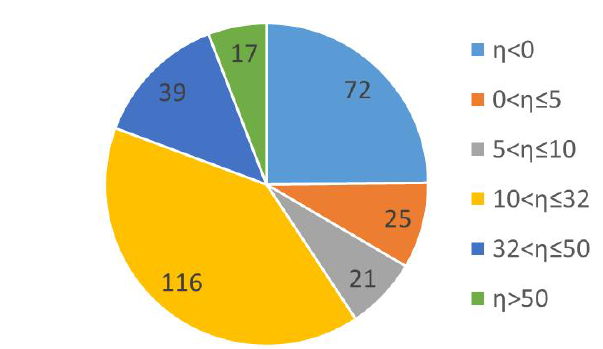
Figure 12—Recovery percent of 290 single sand bodies in a block of Dagang